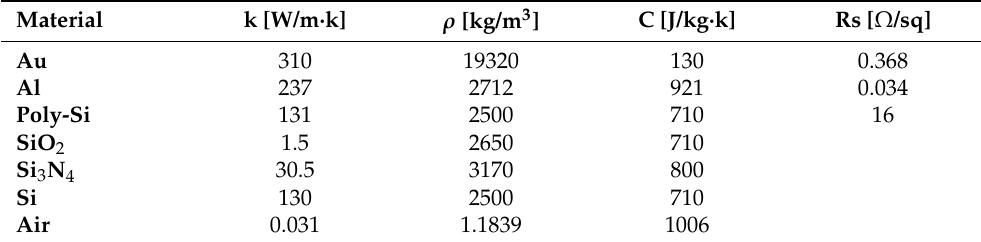
Table 1. Physical and electrical properties of the materials considered.